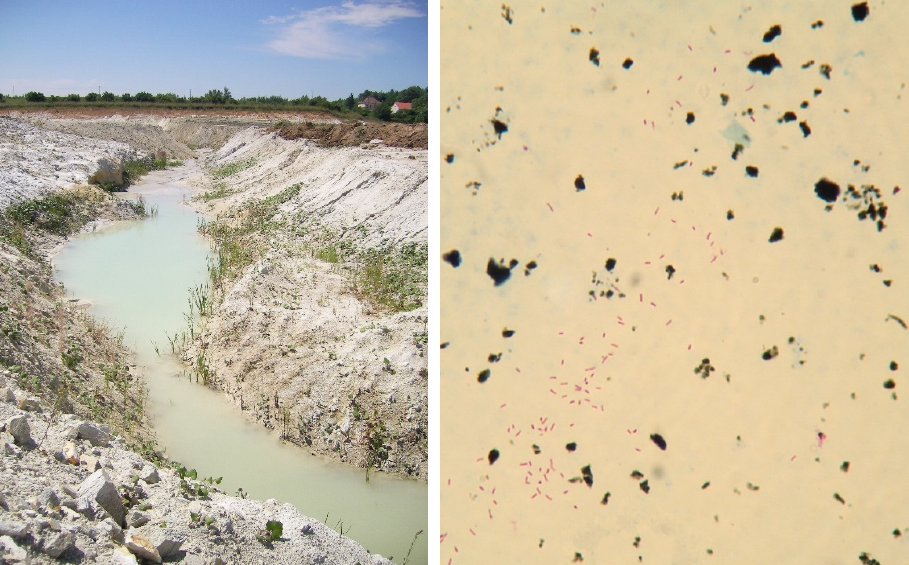
Figure 3. Kaolin extraction by surface mining ( left ) and direct microscopy after the Ziehl–Neelsen staining of the kaolin used as feed supplement ( right ; magnified 800 times). This sample was culture-positive for M. avium ssp. hominissuis (Photo I. Pavlik and V. Beran).